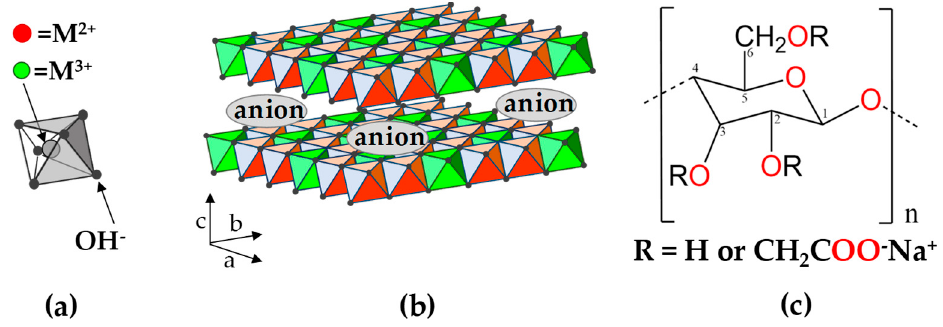
Figure 1. Schematic representation of ( a ) hydroxide ions coordinated to metal cation in an octahedral arrangement, ( b ) layered double hydroxide (LDH) structure comprising stacked positive layers intercalated by negative ions, ( c ) monomeric unit of carboxymethylcellulose (CMC).